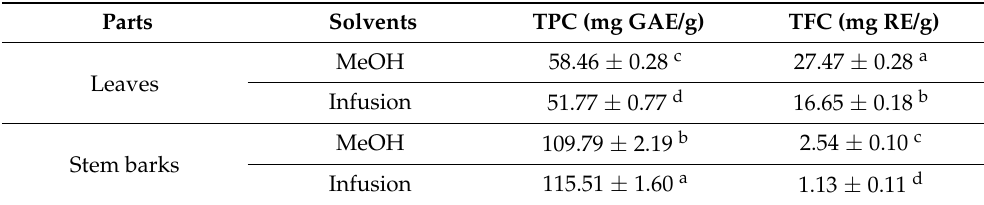
Table 1. Total phenolic and flavonoid contents of Ficus sur extracts.